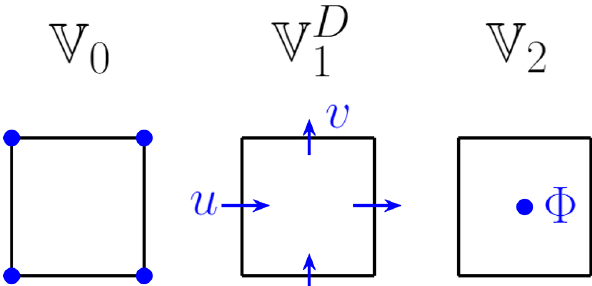
Figure 1. The finite-element function spaces V 0 , V 1 , and V 2 for the div-conforming complex, showing the locations of the velocity components and the